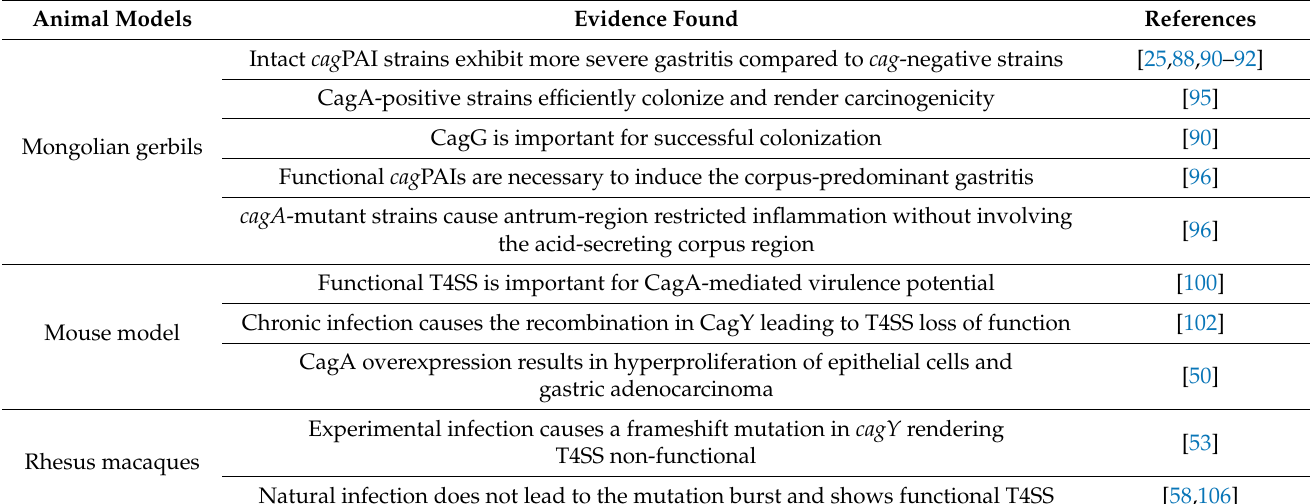
Table 2. The role of Cag pathogenicity islands (PAI) in gastric pathogenicity evidenced by animal models. Animal